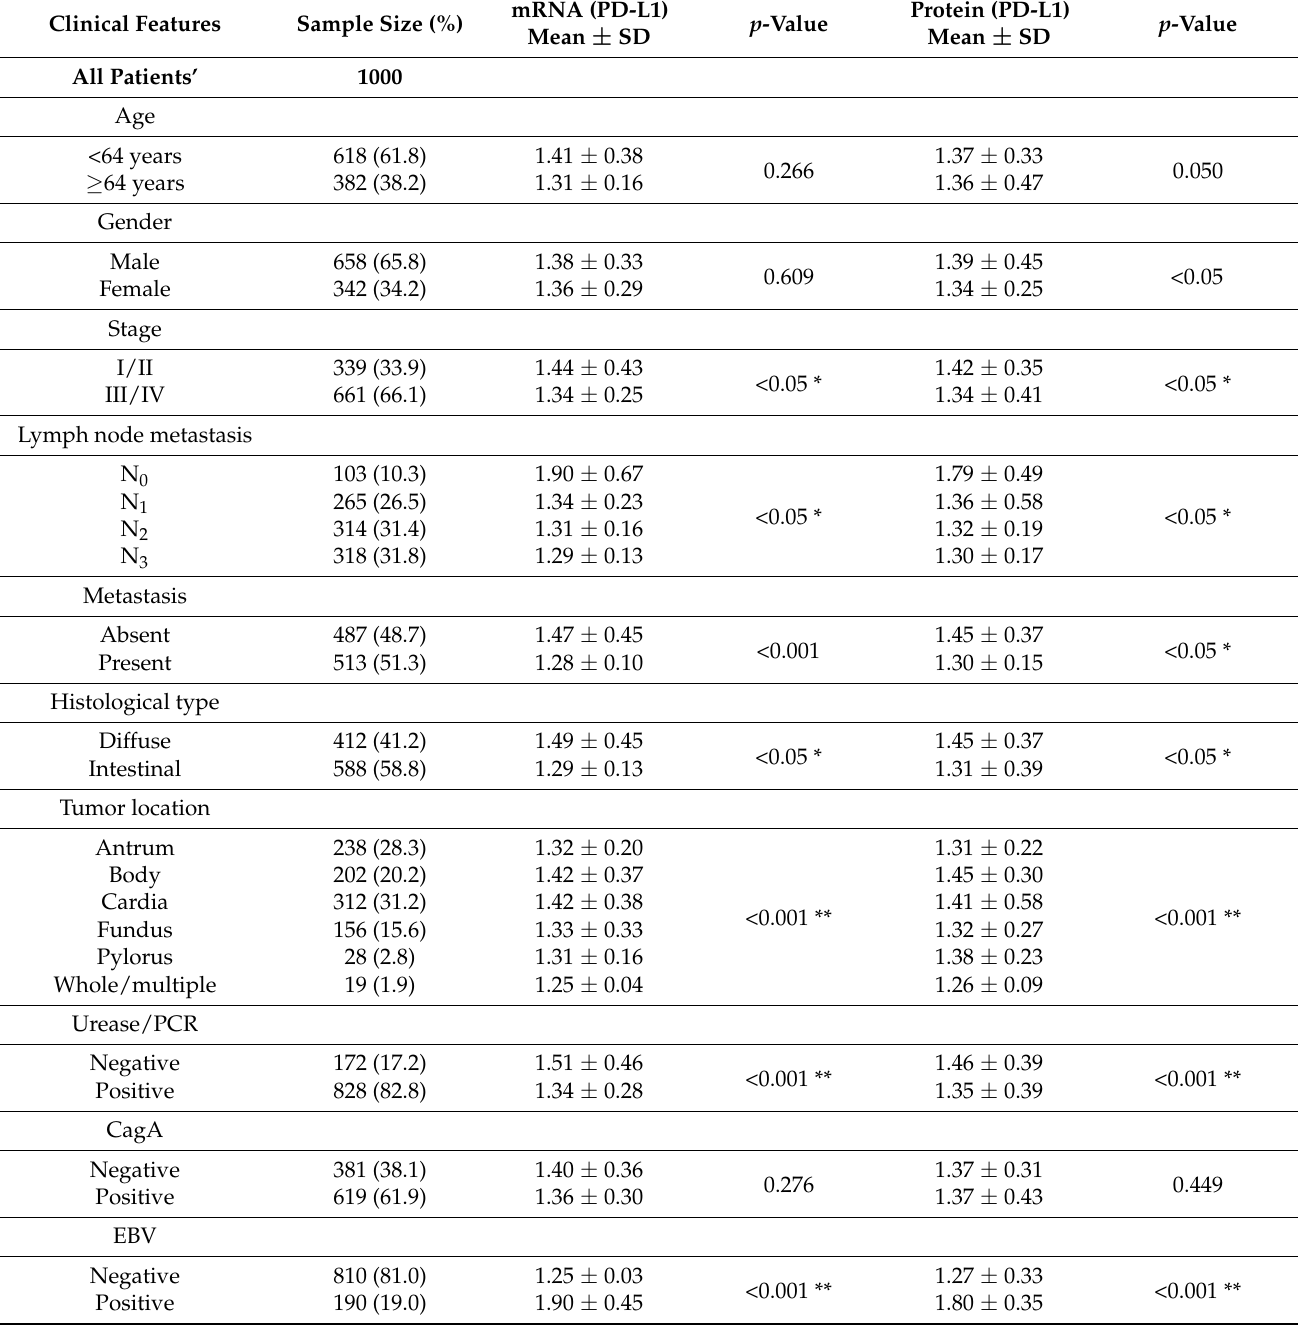
Table 3. Association of PD-L1 expression and clinicopathological